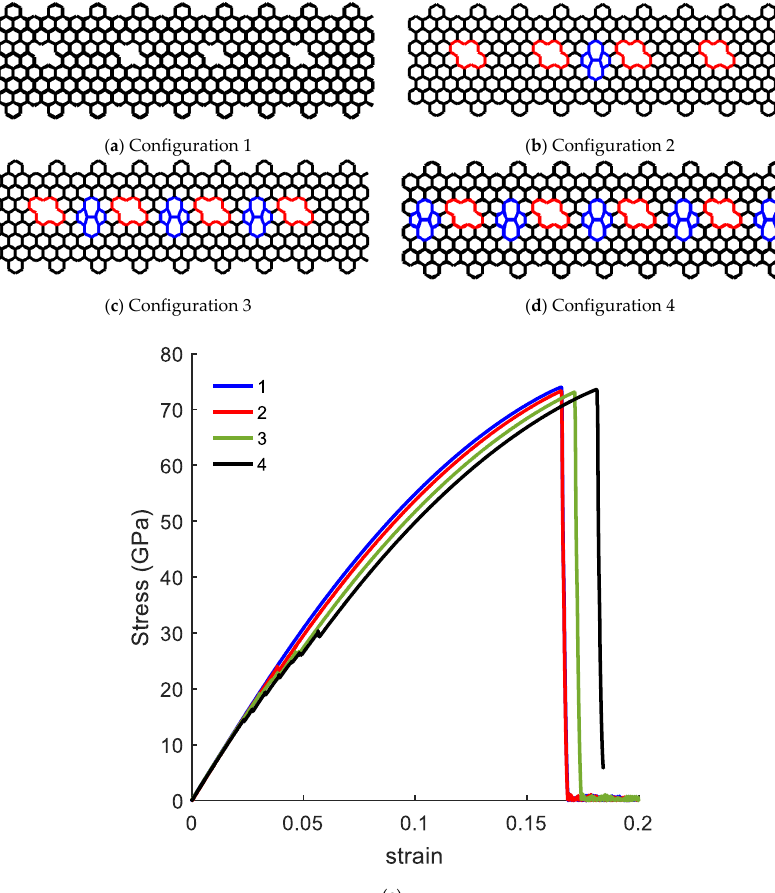
Figure 14. Failure patterns and related atoms and bonds of DV1 and DV2 defects.